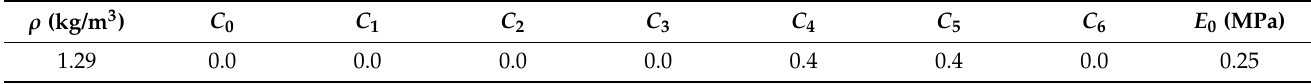
Table 4. Input parameters of the NULL